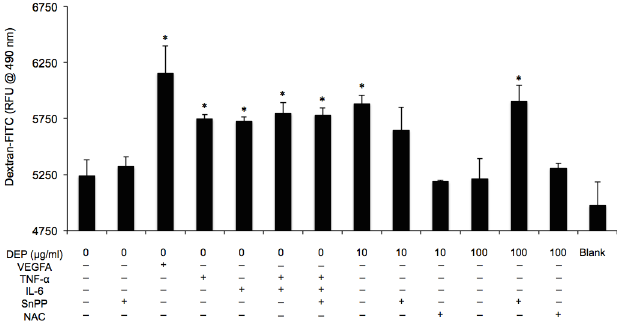
Fig 5. DEPs and the induced cytokines caused in vitro capillary permeability independently of HO-1 activation. FITC-dextran was added to endothelial tubes for 4 h after a 24-h exposure to different treatments. The RFU was determined for each sample after washing of the endothelial tubes.